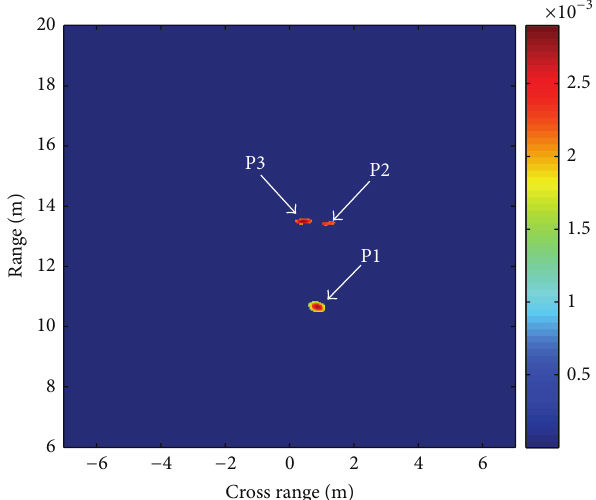
Figure 11: After CFAR detection of Figure 10, ghosts are detected in the